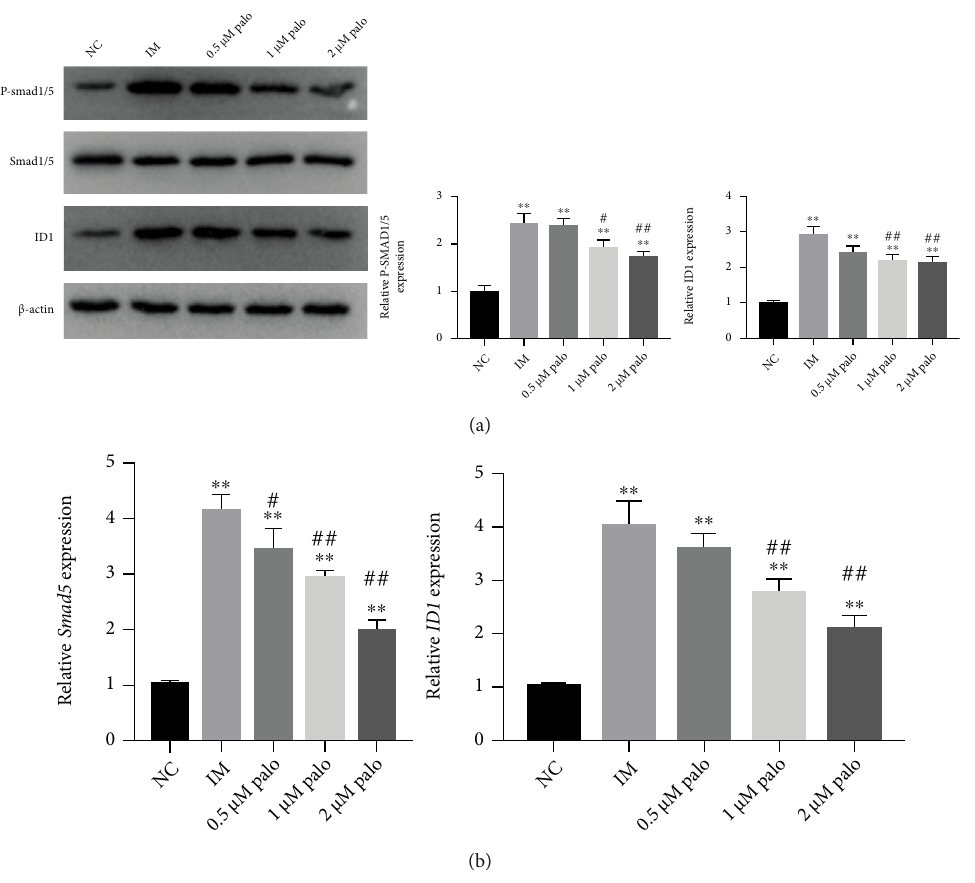
Figure 3: Smad signaling pathway was related to in fl ammatory microenvironment. (a) Western blot analysis and relevant quantitative analysis of P-Smad1/5, Smad1/5, and ID1 in TSCs. Data are means ± SD ( n = 3 ). ∗ p < 0 : 05 and ∗∗ p < 0 : 01 . # p < 0 : 05 and ## p < 0 : 01 . mRNA expression analysis of Smad5 and ID1. Data are means ± SD ( n = 3 ). ∗ p < 0 : 05 and ∗∗ p < 0 : 01 . # p < 0 : 05 and ## p < 0 : 01